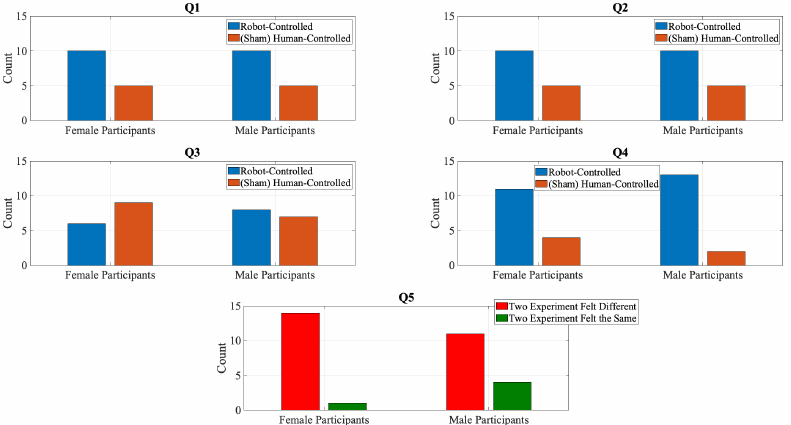
Figure 2. Participants’ responses to Q1 through Q5 of the experiment-specific questionnaire.